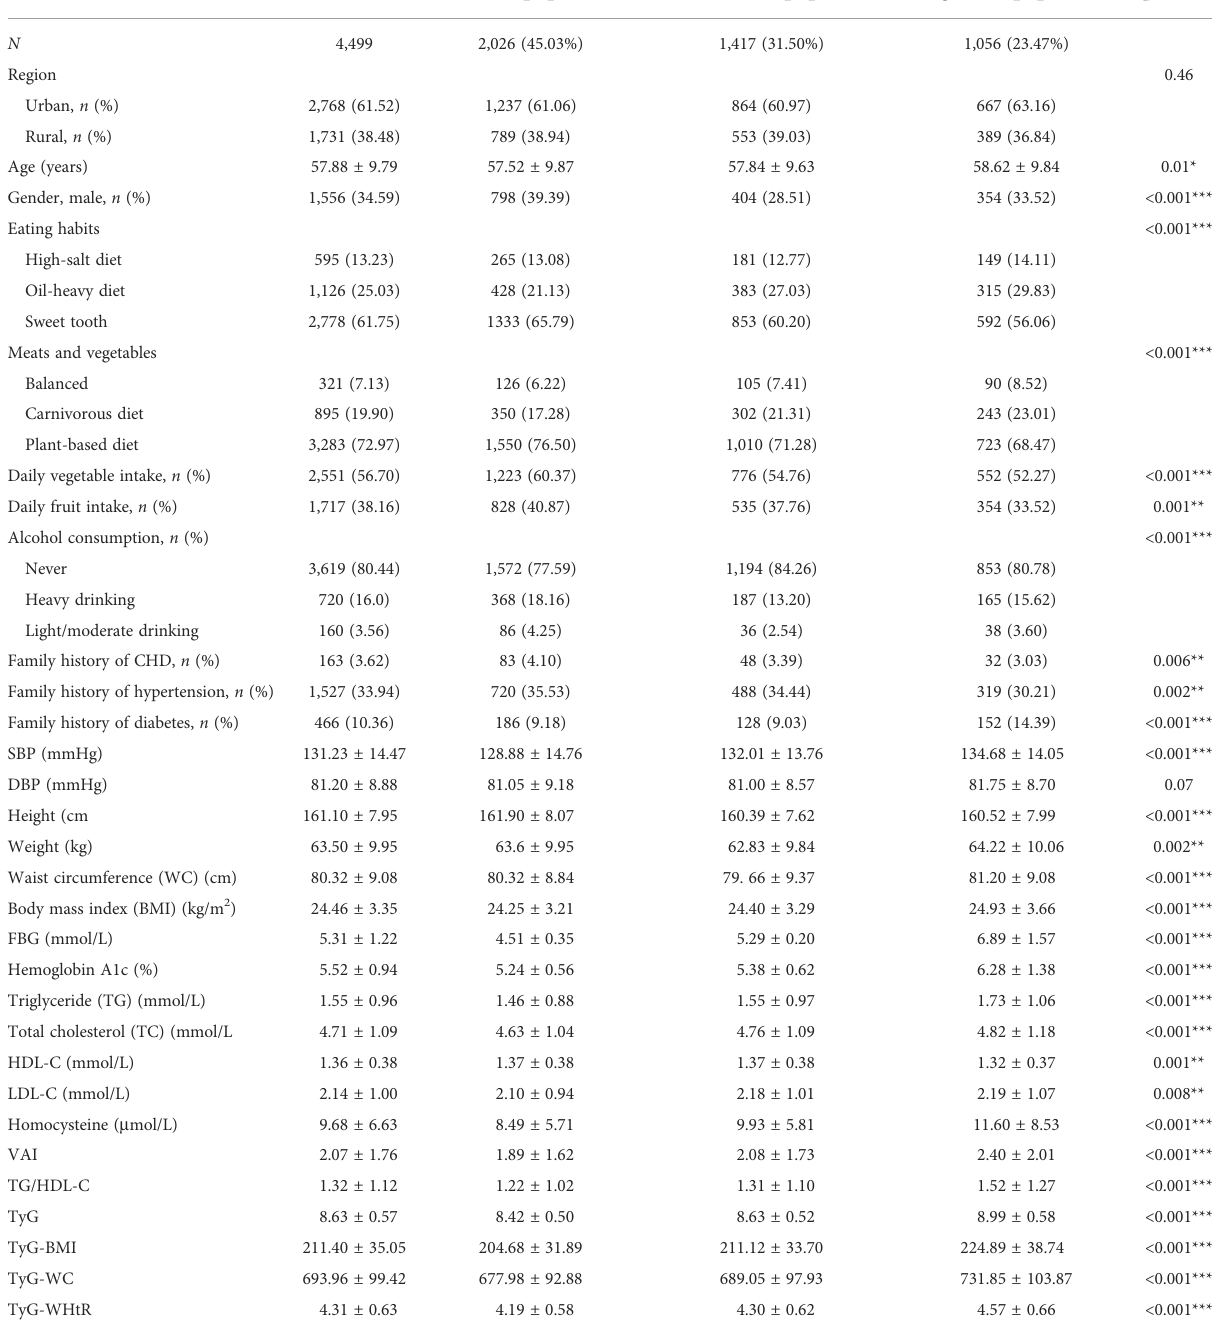
TABLE 1 Baseline characteristics of all